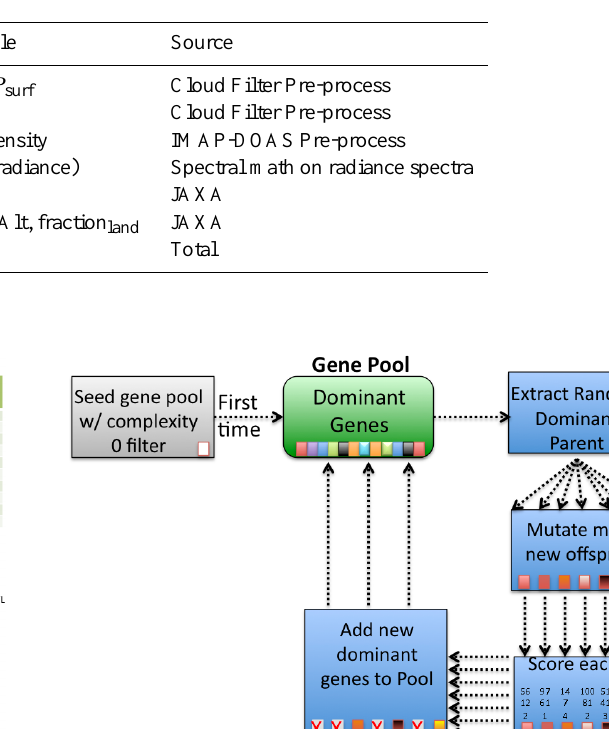
Table 1. Features considered as input to the GOSAT sounding selector construction.